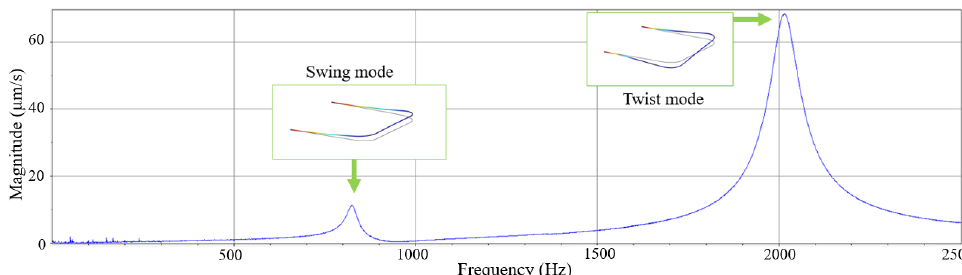
Figure 8. Measured vibration spectrum of air-filled tube detected by LDV. A periodic chirp signal with an amplitude of 30 mV was applied to the tube as an input voltage. The measured resonance frequencies and quality factors are 822 Hz and 27 for the swing mode, and 2015 Hz and 26 for the twist mode, respectively. Table 3. Measured resonance frequencies in twist and swing mode, and the quality factor in swing mode. During flow measurements, the device is actuated in resonance in the twist mode. Coriolis forces due to mass flow will actuate the swing mode at the vibration frequency of the twist mode.